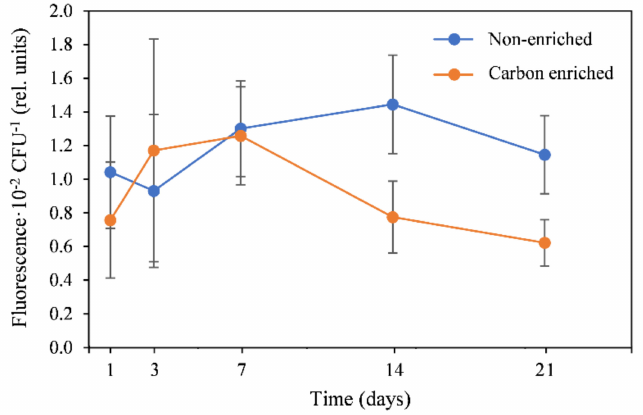
Figure 5. ROS in biofilms grown in non-enriched medium and in medium enriched with inorganic carbon. Data are expressed as mean values of three independent replicates (error bars indicate standard